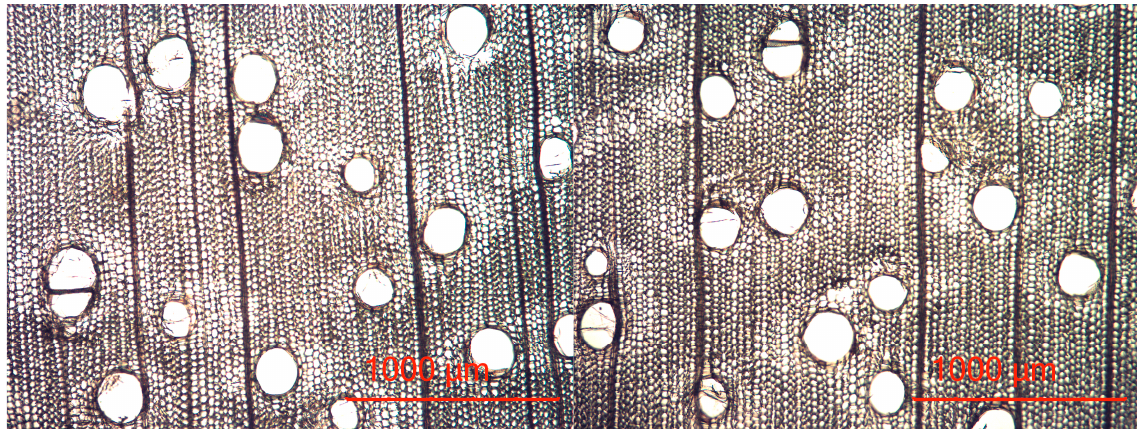
Figure 3. Cross-section of the analyzed wood tissue.